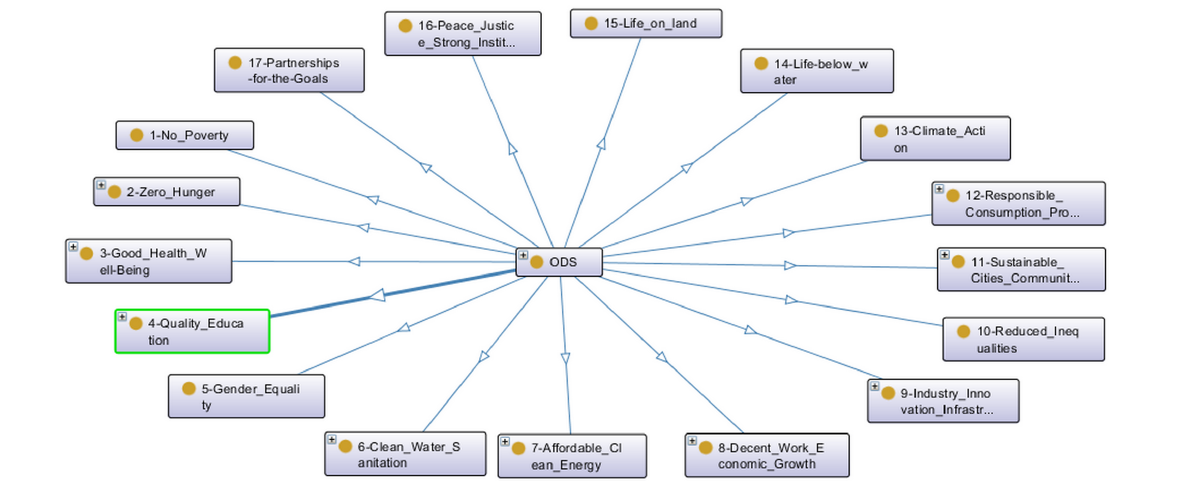
Figure 15. The United Nations Sustainable Development Goals in the higher level of the